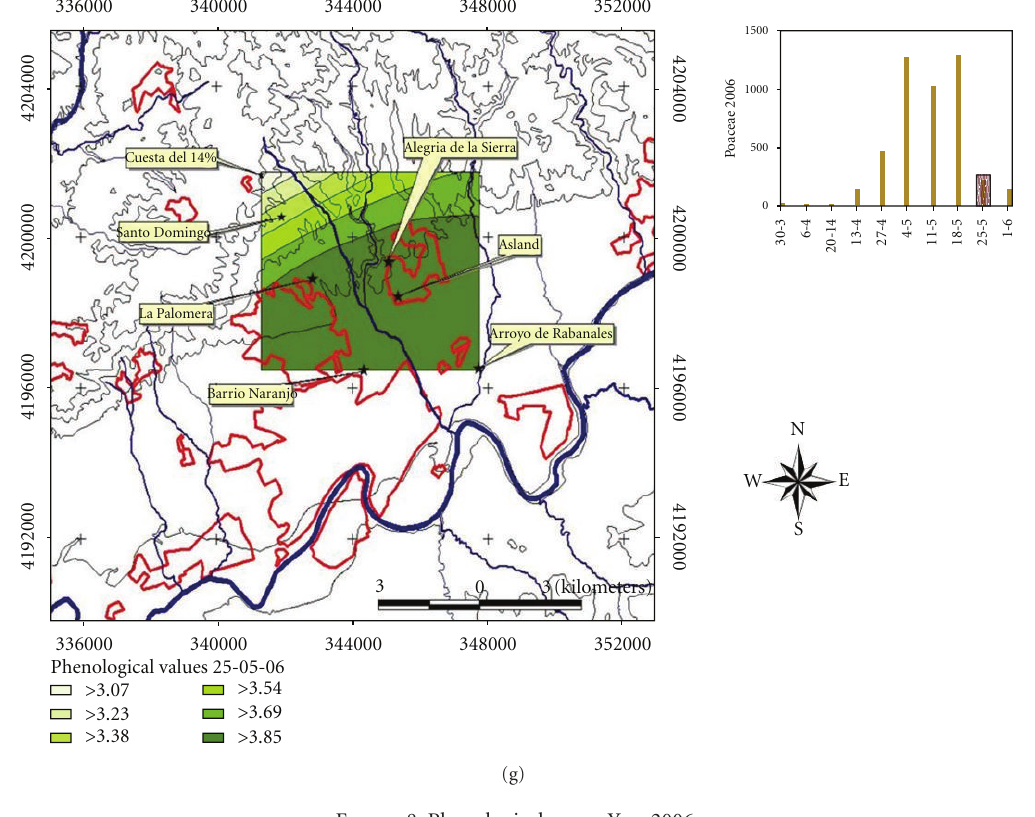
Figure 8: Phenological maps. Year 2006.